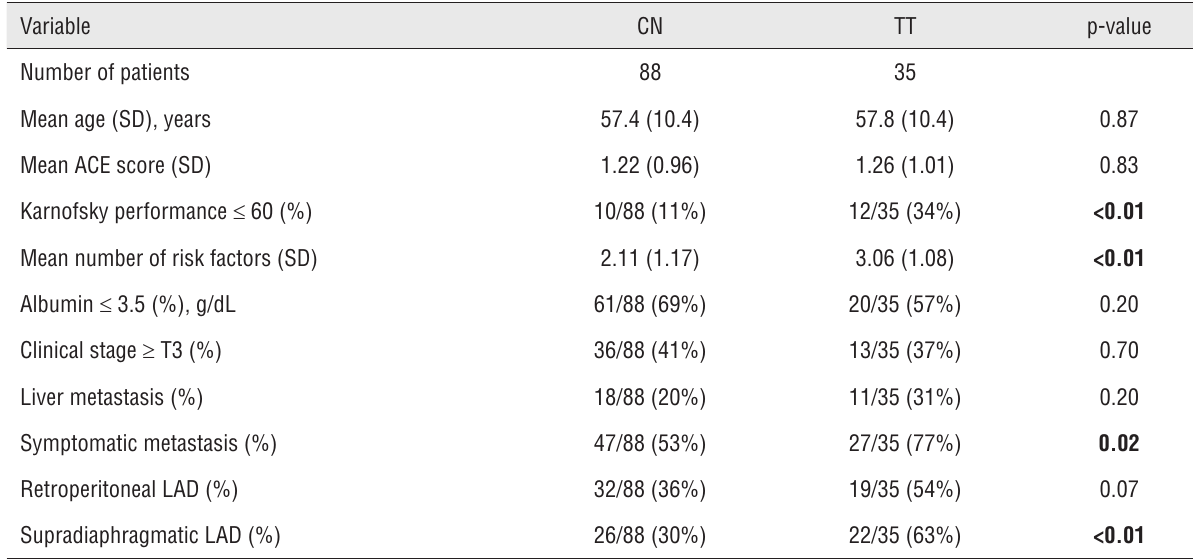
Table 1 - Baseline patient clinical